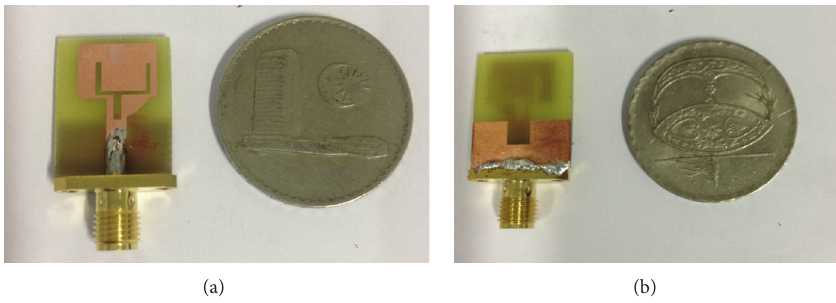
Figure 2: Fabrication of the proposed notched antenna. (a) Front view; (b) back view.